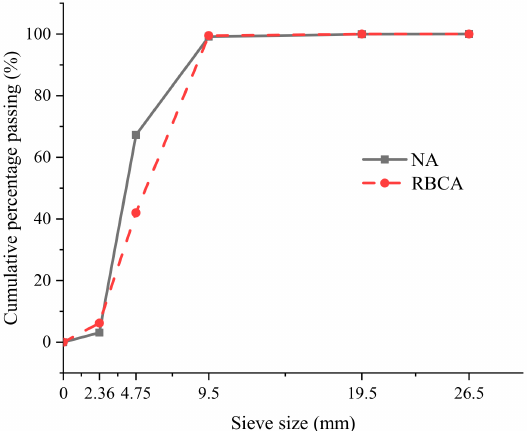
Figure 2. Particle gradation curve of coarse aggregate.